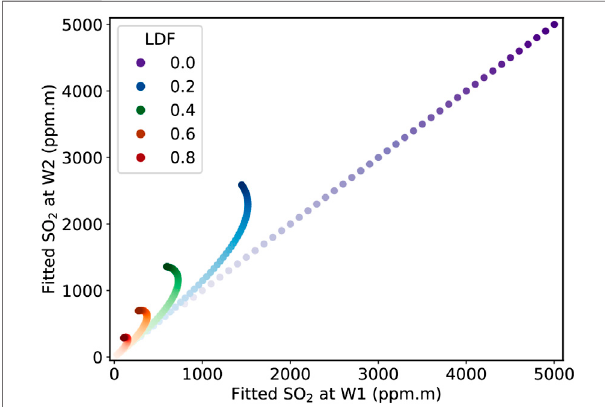
FIGURE 3 | Retrieved SO 2 slant column densities (SCDs) from the analysisofallsyntheticspectrageneratedbyvaryinginputSO 2 between0and 5,000 ppm m and the light dilution factor (LDF) between 0.0 and 0.8 (here